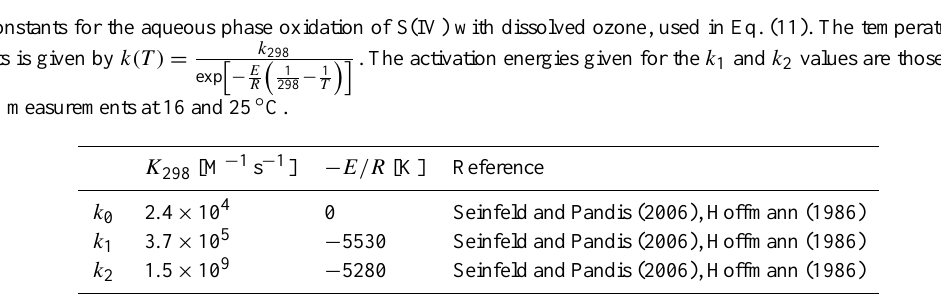
Table 4. A list of the measured and modelled conditions during each experiment. T i is the temperature just before the expansion, and T min is the minimum temperature measured during the expansion. Peak LWC is the maximum condensable water during the expansion, derived from the dew point temperature ( T dew ) and T min . The median drop diameter (modelled) is the largest size reached by the median drop during the expansion and the median dry diameter is taken from the model output just prior to the expansion. The maximum activated fraction is the maximum modelled number of droplets larger than 1µm in diameter during the expansion, divided by the total number of aerosol. The change in measured volume divided by the change in modelled volume is the numerical value for the points plotted in Fig. 11. The maximum pH is the maximum pH reached by the median sized droplet during the expansion (modelled), the NH + from the AMS data just prior to the expansion. The gas phase ammonia mixing ratio was calculated from the AMS data immediately prior to the expansion, as described in Sect. 3 and the number of aerosol is the modelled number of aerosol just prior to the expansion.